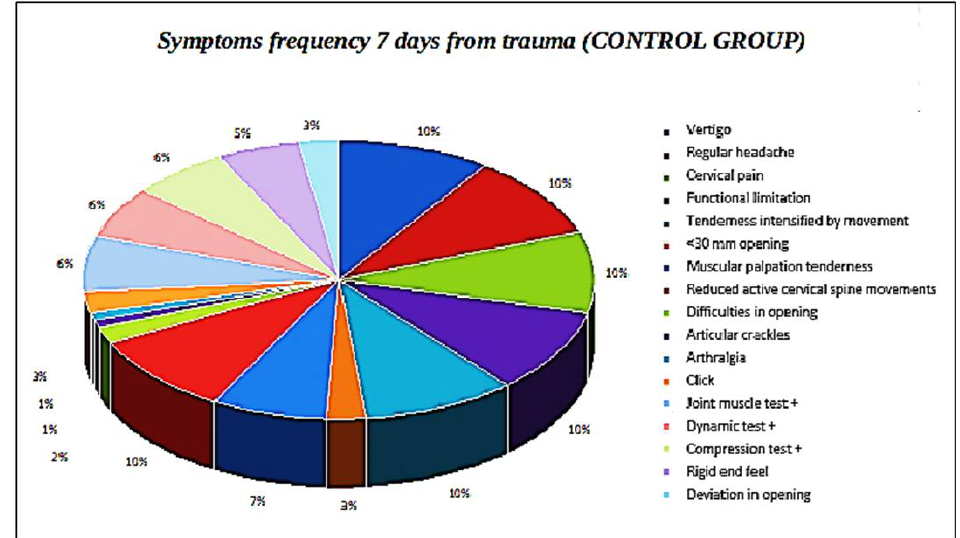
Figure 3. Symptom frequency 7 days from trauma (control group).